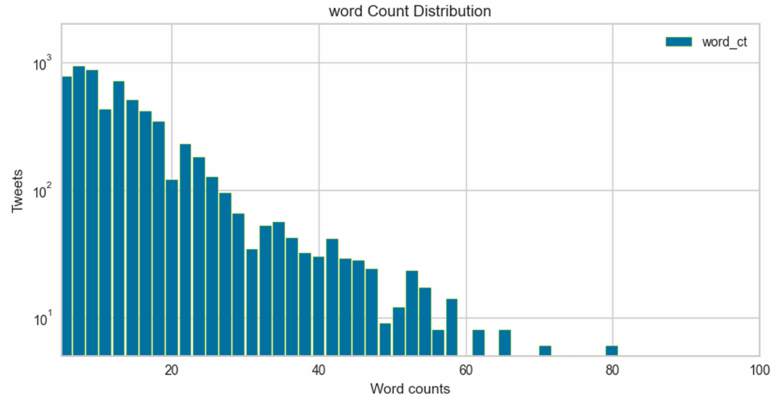
Figure 8. Word count distribution for cyberbullying tweets.